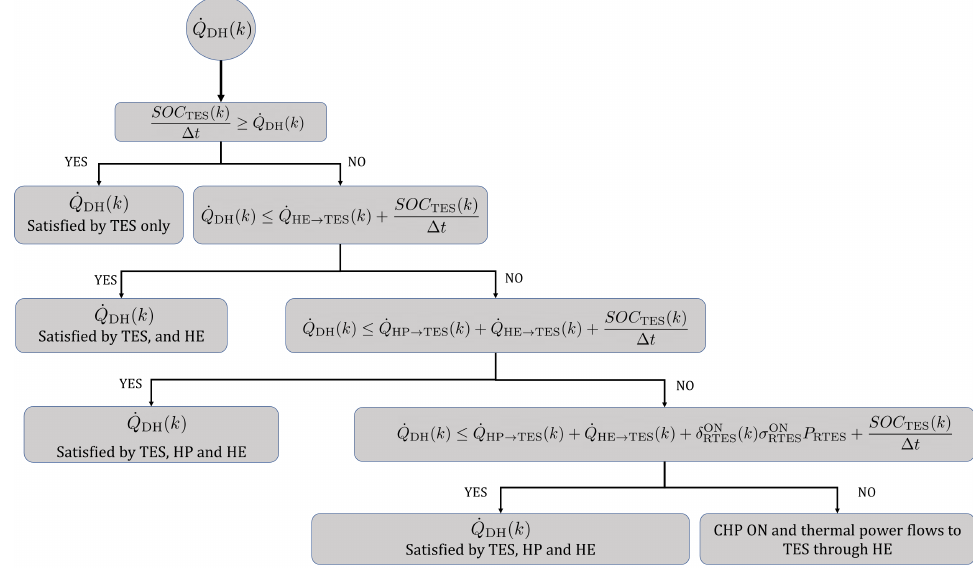
Figure 3. Heat demand satisfaction module.